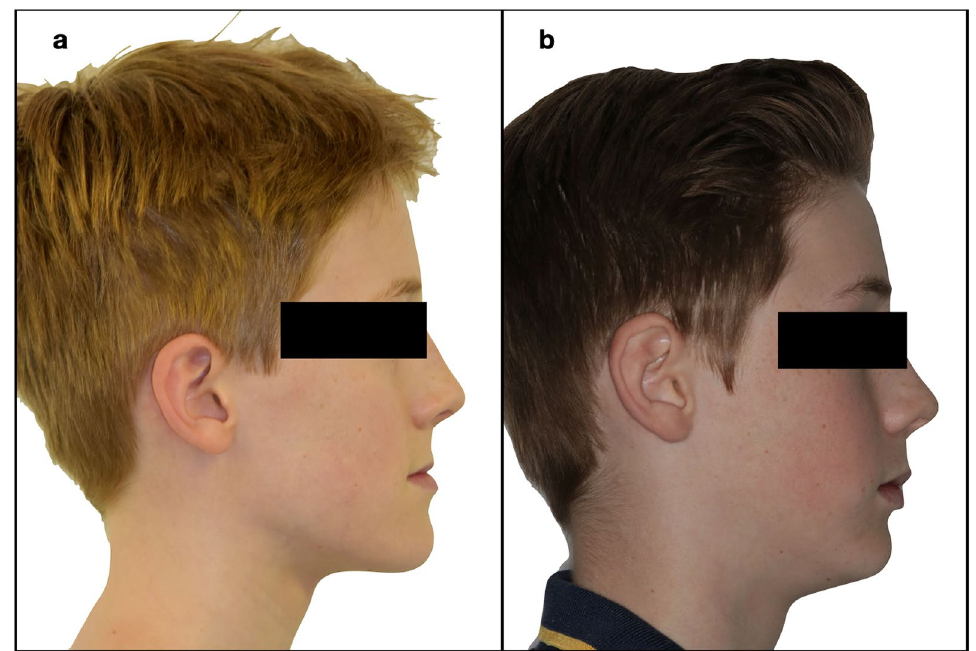
Fig. 6 Before ( a ) and after ( b ) profile comparison. A significant increase in facial convexity and a reduction in chin prominence